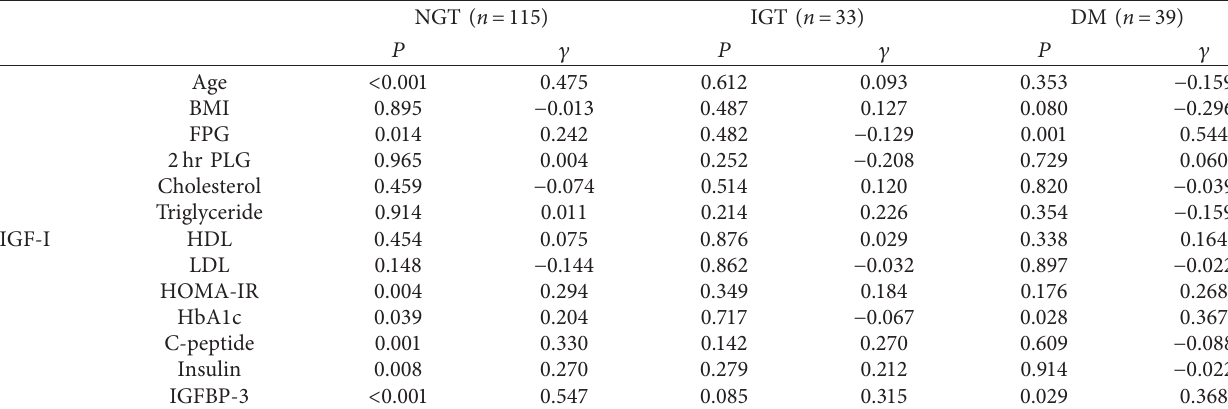
Table 4: Simple correlation ( c ) analysis between serum IGF-I and clinical